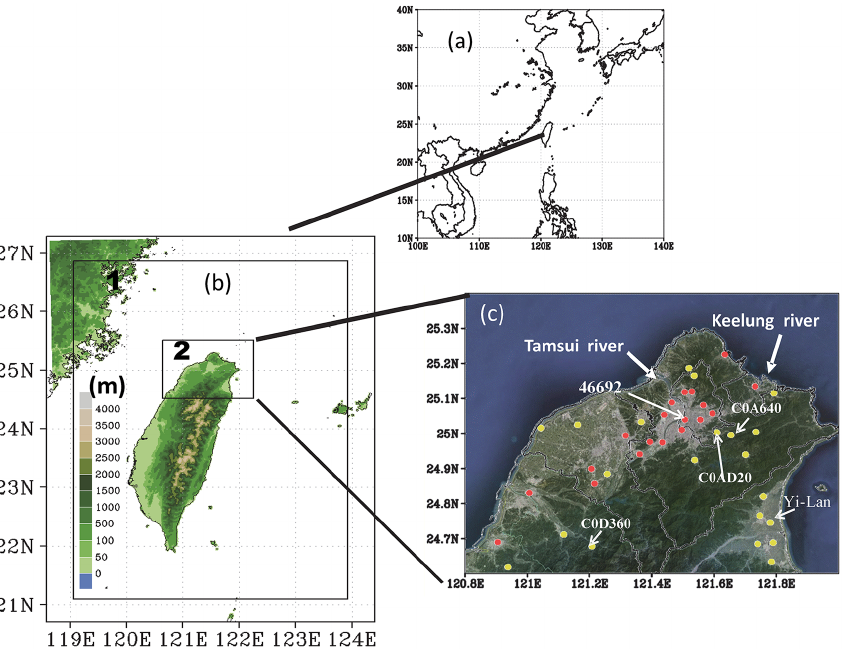
Figure 1. Location of Taiwan (a) , simulation domains (b) , and locations of urban (red dots) and non-urban (yellow dots) meteorological stations (c) in northern